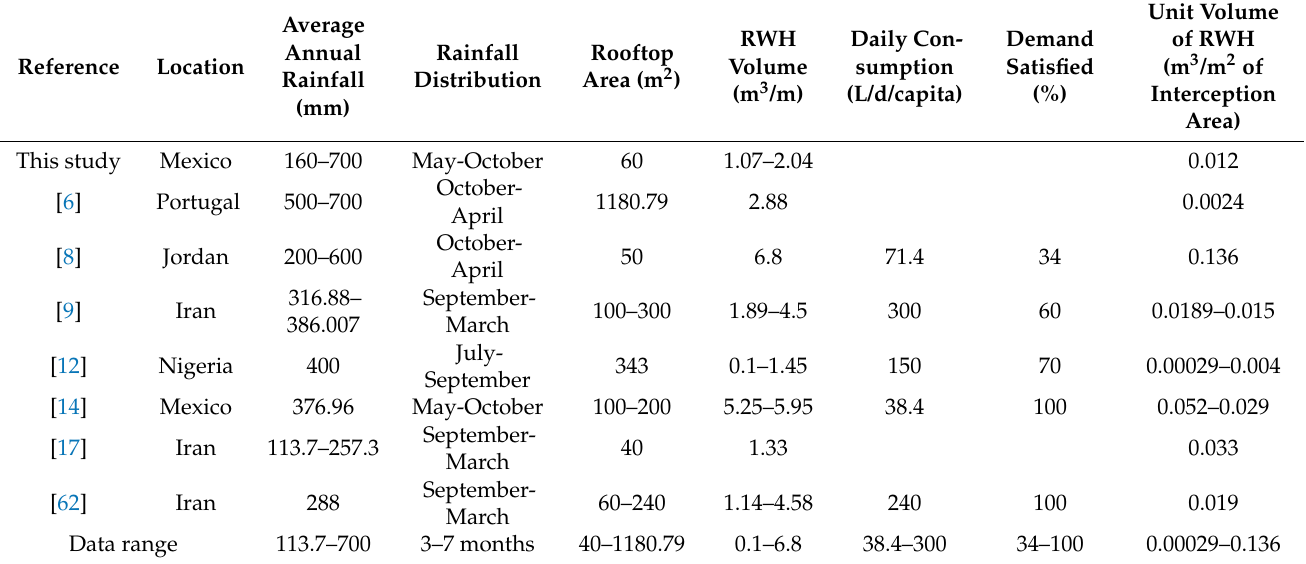
Table 6. Comparison of RWH approaches in different semi-arid urban